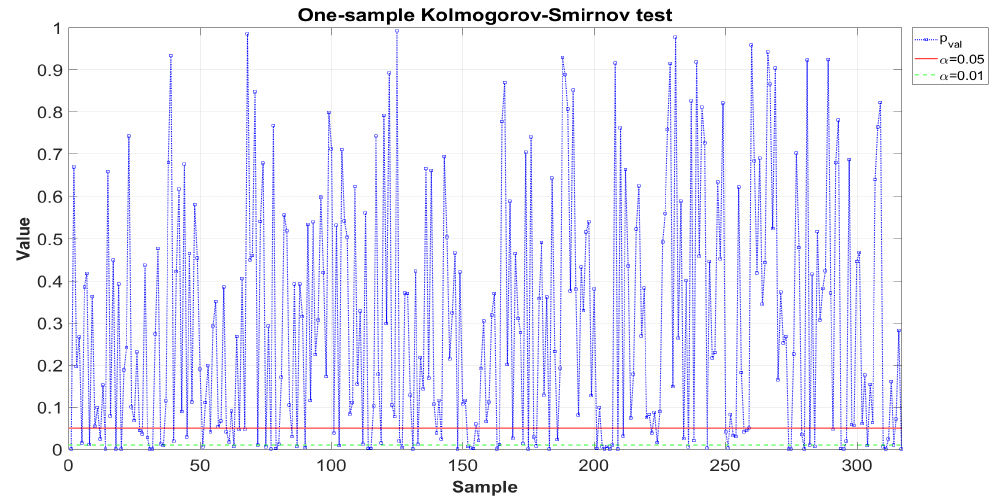
Figure A10. Approximation errors (one sample Kolmogorov–Smirnov test).